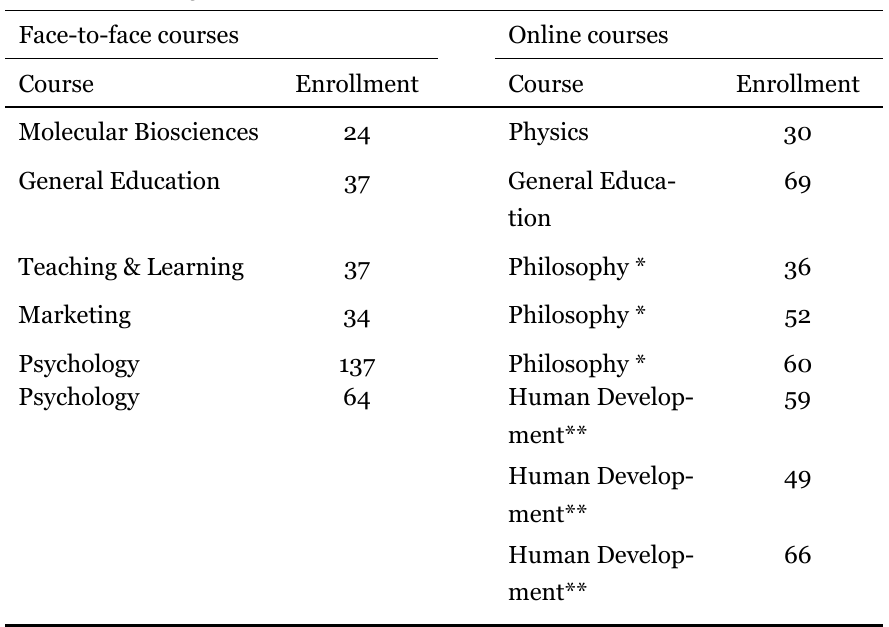
Courses in Study with Enrollments Face-to-face courses Online courses Course Enrollment Molecular